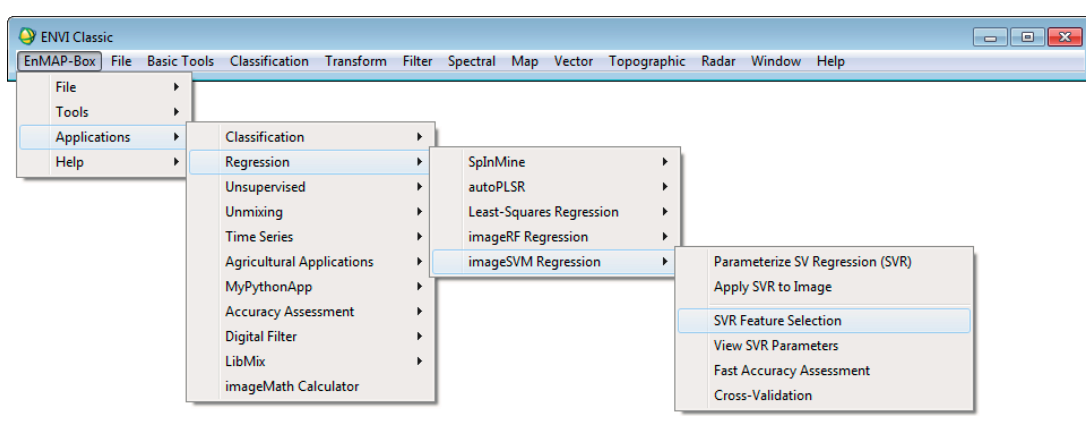
Figure 2. ENVI classic menu with integrated EnMAP-Box